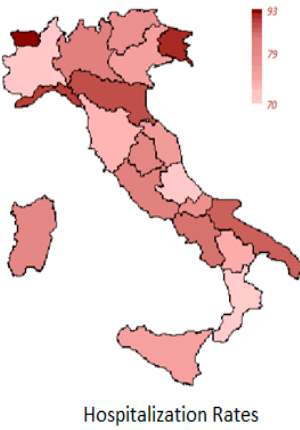
Figure 1. Overall regional cancer standardized hospitalization rates (SHR) per 100,000 in the population aged 0–100 years old (average annual value). Table 2. Standardized hospitalization rate (SHR) per 100,000 and overall number of new hospitalizations due to cancer per region and province from 2007 to 2011. Pediatric patients aged 0–19 years